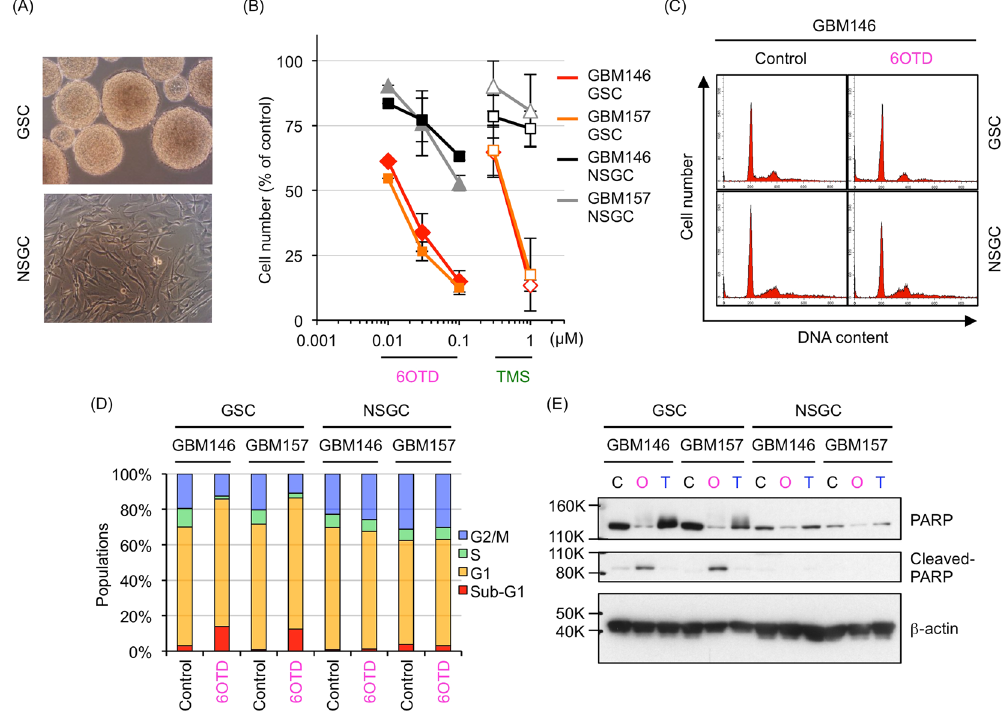
Figure 3. 6OTD preferentially targets glioma stem cells rather than non-stem glioma cells. ( A ) Representative photos of glioma stem cells (GSCs) and non-stem glioma cells (NSGCs). GSCs were differentiated into NSGCs by serum stimulation for 7 days 12, 21 . ( B ) Effects of 6OTD and TMS on the growth of two patient-derived GSCs and NSGCs. Cells were treated with indicated concentrations of the compounds for 6 days. Graphs indicate the mean ± SD of triplicate assays. ( C ) Cell-cycle analysis of GSCs and NSGCs treated with 6OTD (0 or 100 nM, 5 days) by flow cytometry with propidium iodide (PI) staining, with the number of cell ( x -axis) and DNA content ( y -axis). Indicated histograms are the representative results of duplicate experiments. ( D ) Quantitation of the cell-cycle distribution of control and 6OTD-treated GSCs and NSGCs in ( C ). ( E ) Detection of PARP cleavage in GSCs and NSGCs. Cells were lysed 5 days after DMSO, 6OTD (100 nM), or TMZ (10 μ M) treatment, and